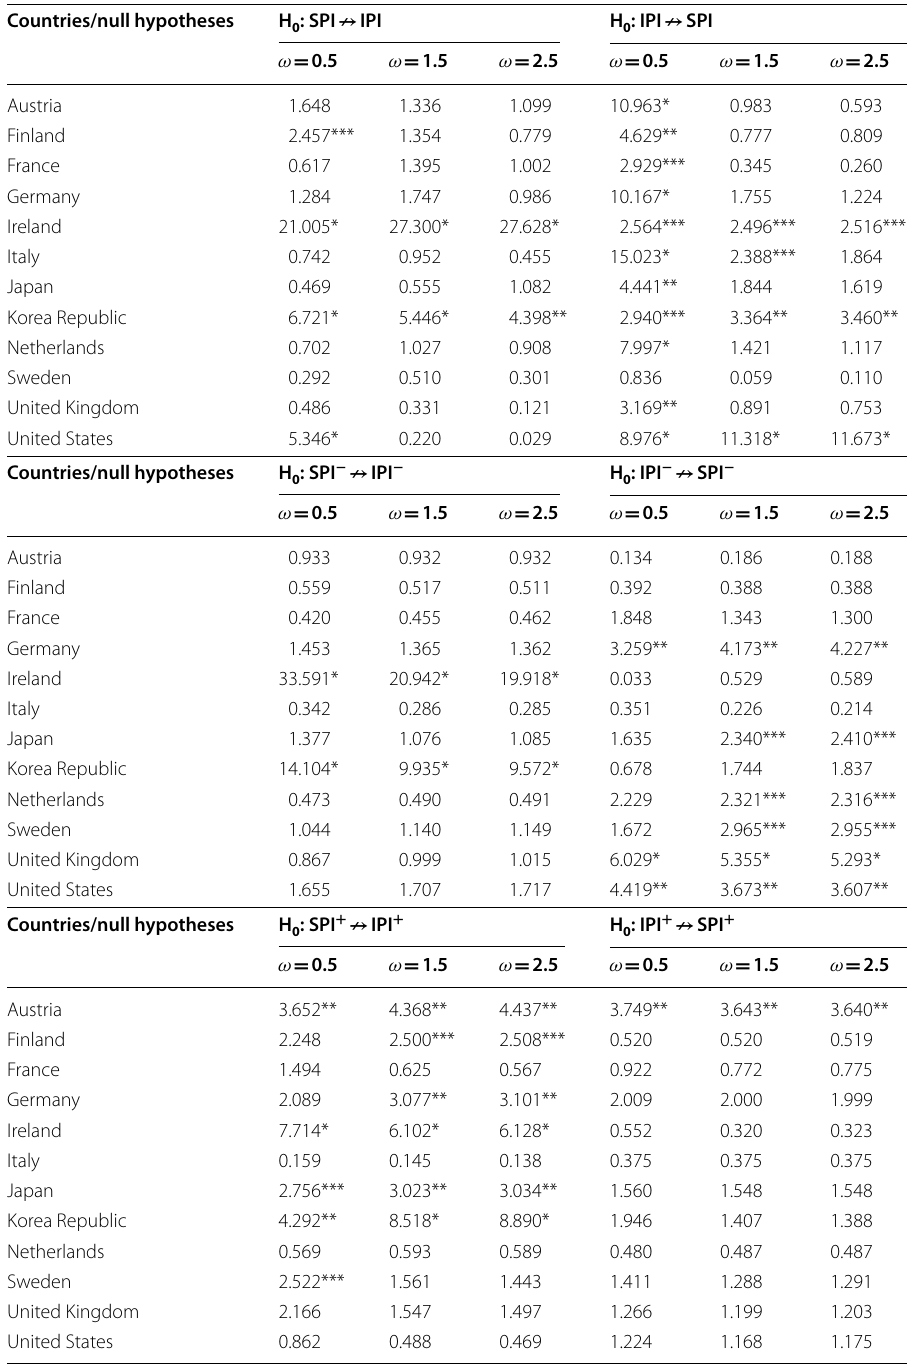
*, **, ***The significance at the 1, 5, and 10% levels, respectively. Critical values are 2.315, 3.016, 4.654 at the 10%, 5%, 1% levels,